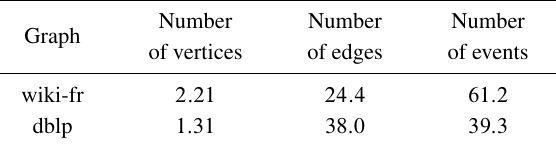
Table 3 Statistics of the temporal graphs used. ( (cid:2) 10 6 )